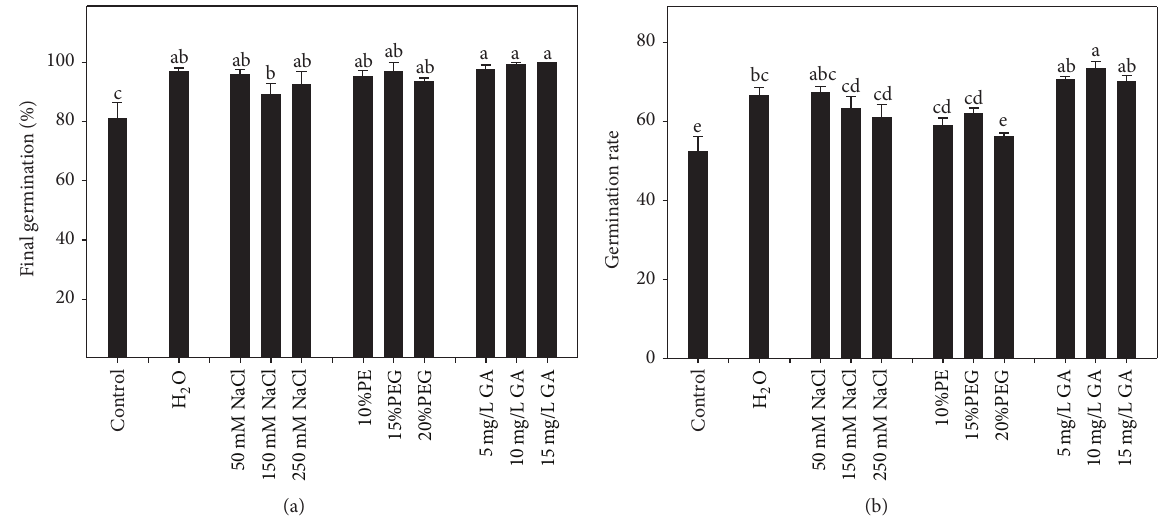
Figure 3: Effects of pretreatment reagents on final germination percentage and germination rate of maize ( 𝑛 = 4